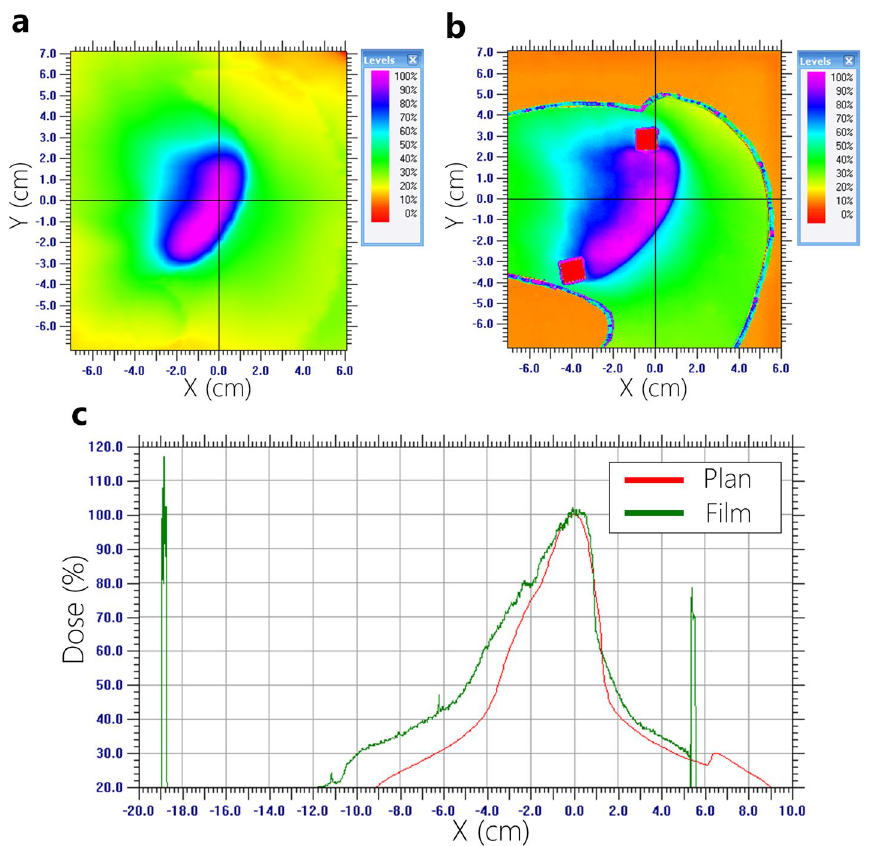
Figure 11. Dose profile analysis (measured film vs. planned dose) using 6-MV based on AXB Algorithm. ( a ) planned dose, ( b ) measured dose, ( c ) comparison of dose